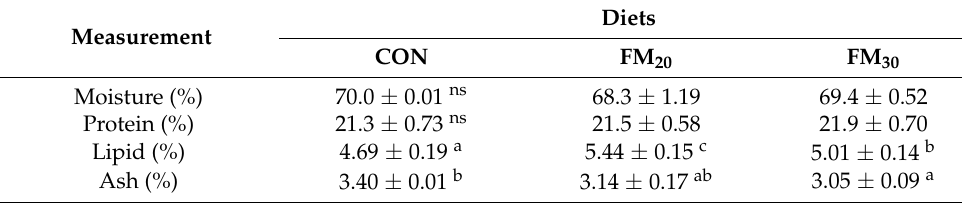
Table 5. Whole-body proximate composition of growing olive flounders ( Paralichthys olivaceus ) fed experimental diets for 20 weeks (% on wet